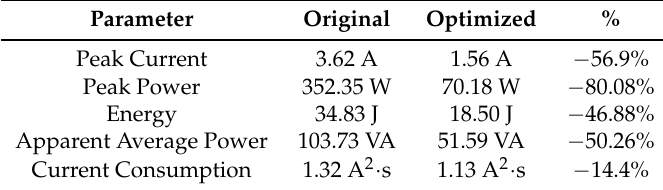
Table 3. Simulation with load. Final velocity: 30 rads/s. Final time: 0.5 s.